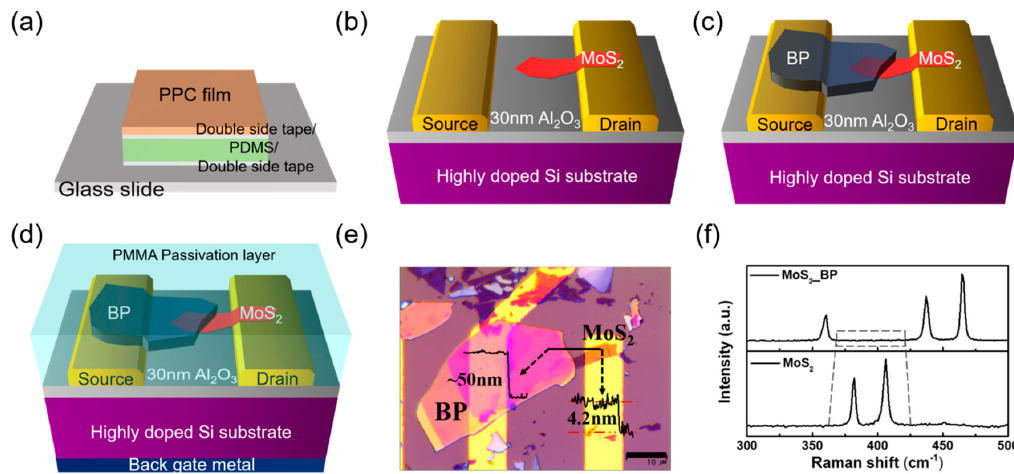
Figure 1. ( a ) Schematic of stamp (polypropylene carbonate (PPC)/double-sided tape/polydimethylsiloxane (PDMS)/double-sided tape/glass slide), with the 2D flake transferred directly onto the PPC film. ( b ) MoS 2 transferred onto the drain electrode (5-nm/45-nm Ti/Au) and gate oxide (30-nm Al 2 O 3 ). ( c ) Black phosphorus (BP) flake transferred quickly to the substrate using the same method. ( d ) Device passivated using polymethylmethacrylate (PMMA) film. ( e ) Optical image of MoS 2 /BP (4.2 nm/50 nm) heterojunction. ( f ) The thickness of flakes was measured using Raman spectra (using a 514-nm laser) of the molybdenum disulfide (MoS 2 )/BP stack. The lower panel shows